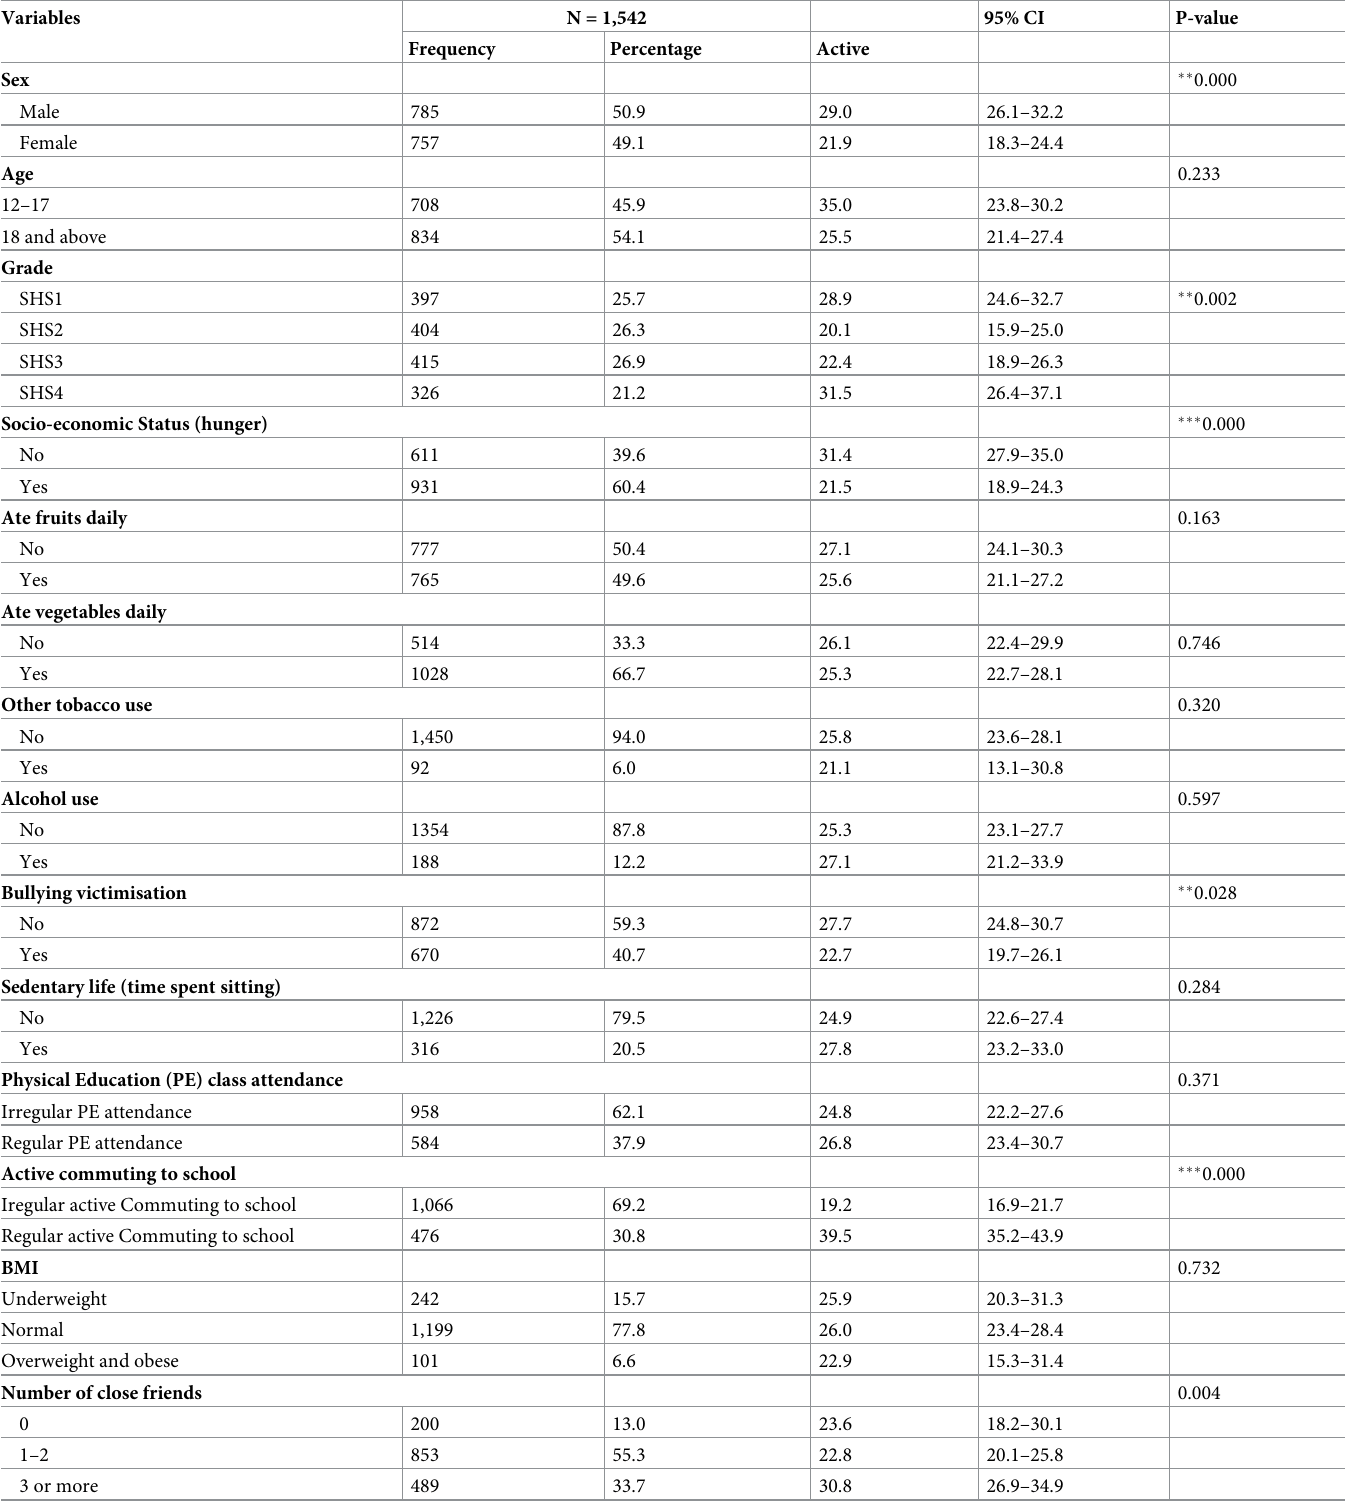
Table 1. Distribution of the sample according to level of physical